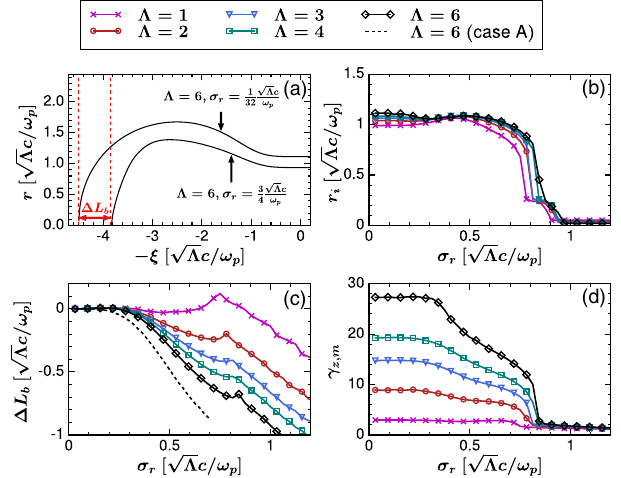
FIG. 2. (a) Trajectories of the most energetic sheath electrons ffiffiffiffi p ffiffiffiffi p 3 Λ ¼ 6 . The change in Λ c= ω Λ c= ω for σ r ¼ 1 p and p when 32 4 the bubble length Δ L b is shown by the red dashed lines. (b) The initial position of the plasma sheath electrons r i , (c) the change in bubble length Δ L b , and (d) the maximum sheath electron forward velocity γ z;m as a function of the spot size σ r for quasistatic ffiffiffiffi p Λ c= ω plasma wakes. Lengths are normalized by p . Nonevolv- ing electron drivers with energy γ b ¼ 20000 and σ z ¼ 0 . 7 c= ω p were used. Δ L b is also calculated from the evolving wake in case A [see Fig. 1] and plotted in (c) with dashed black